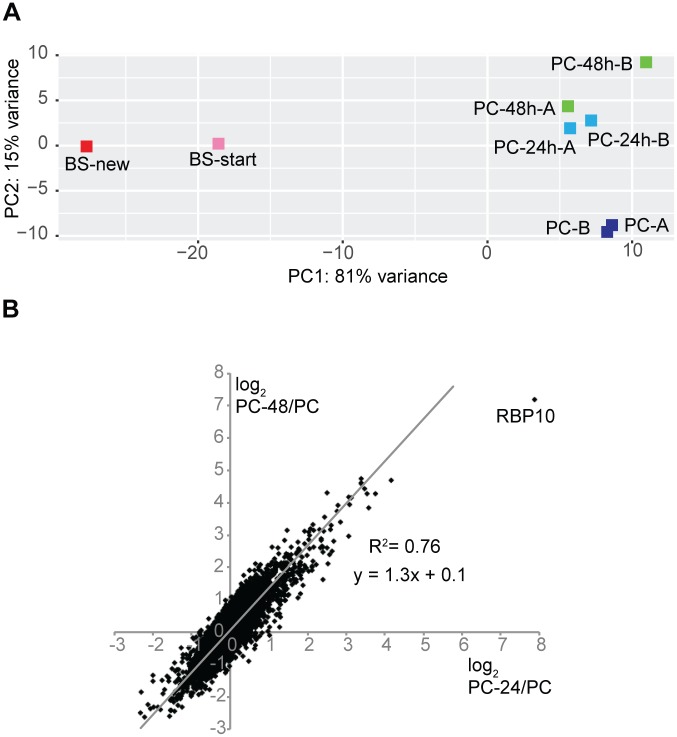
Analysis of transcriptomes of EATRO1125 with forced RBP10 expression.A) Principal component analysis showing the clustering of procyclic forms, bloodstream forms and cells with induced RBP10 expression. B) Correlation between the effects of 24h and 48h RBP10 expression for 7000 unique genes. For each gene, the log2 of the ratio between the induced and uninduced cultures is shown.